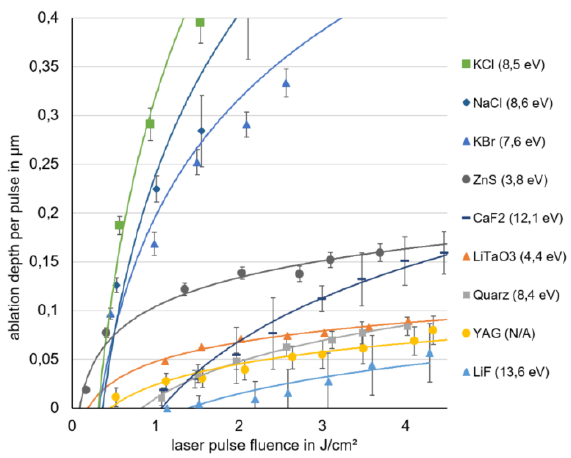
Fig. 1. Ablation depth per pulse for different wide band gap materials